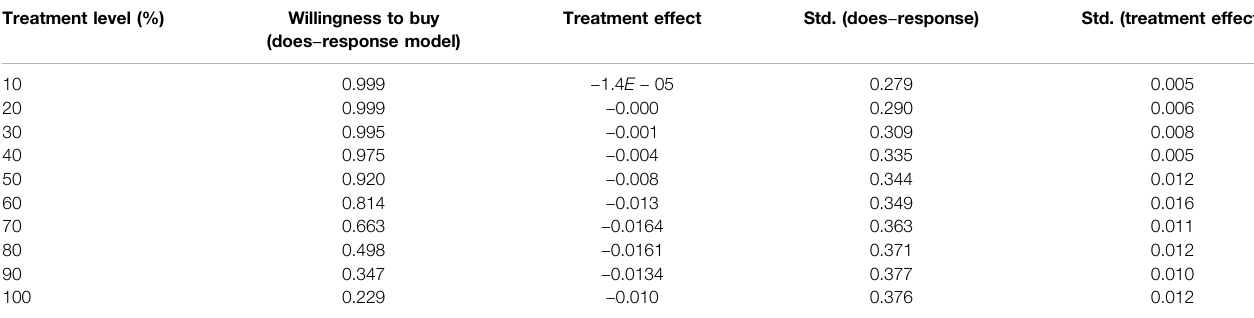
TABLE 7 | Consumer ’ s willingness to buy Chinese EVs and prediction of the turning point. Treatment level (%)